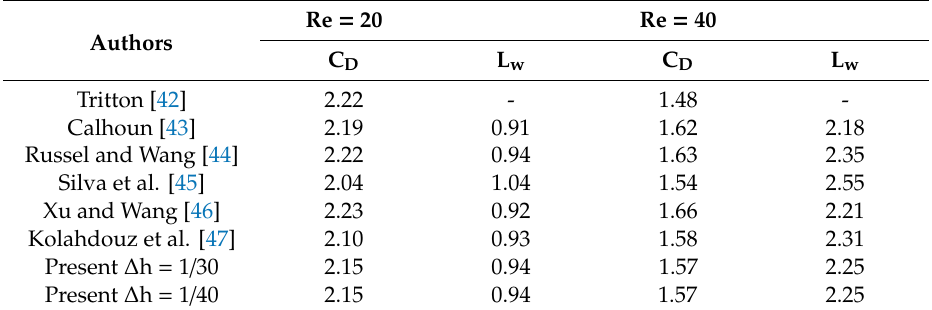
Table 1. Drag coe ffi cient and reattachment length for flow past a stationary cylinder at Re = 20 and Re = 40.